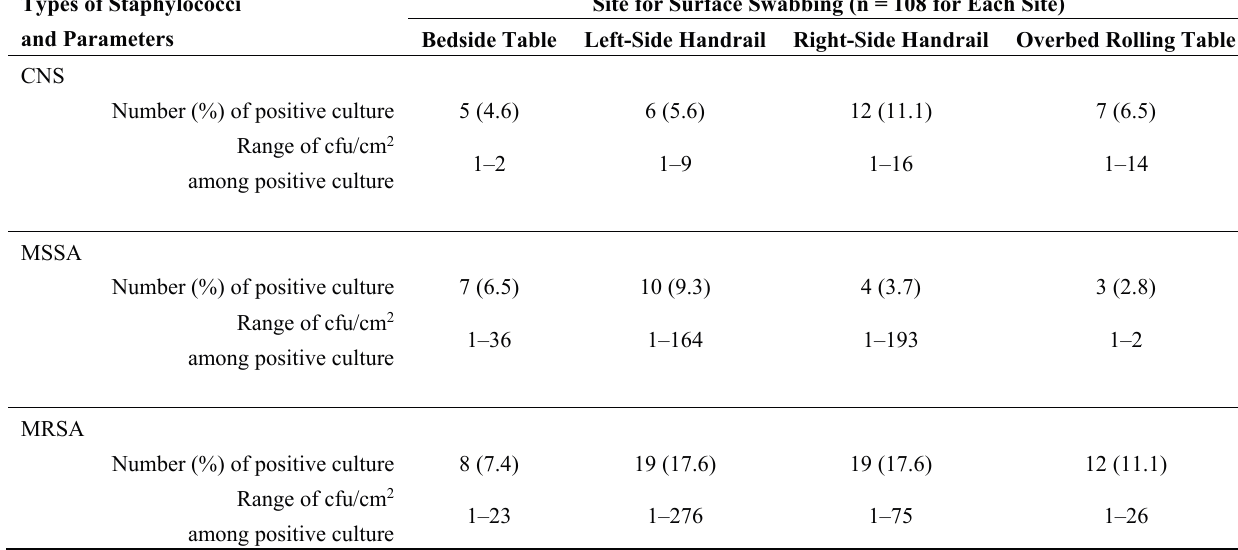
Table 3. Number, percentage and the range of colony numbers of the three staphylococcal species recovered from the surface swabbing sites at 08:00 hours (an hour after the hypochlorite